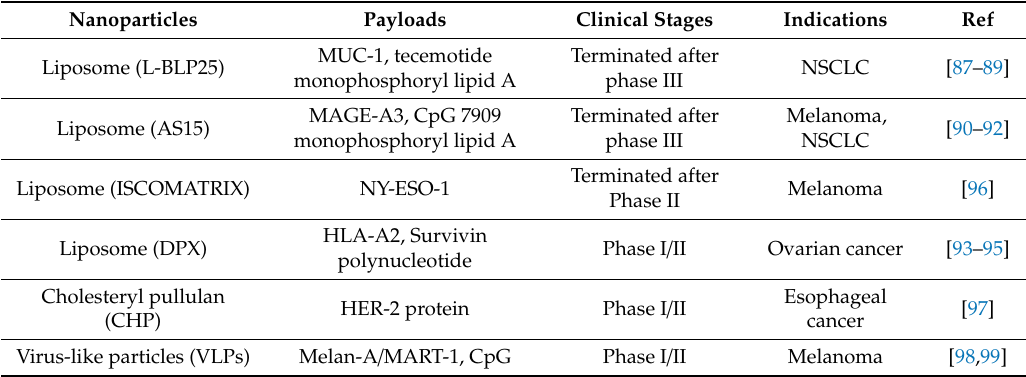
Table 2. Nanoparticles evaluated in clinical